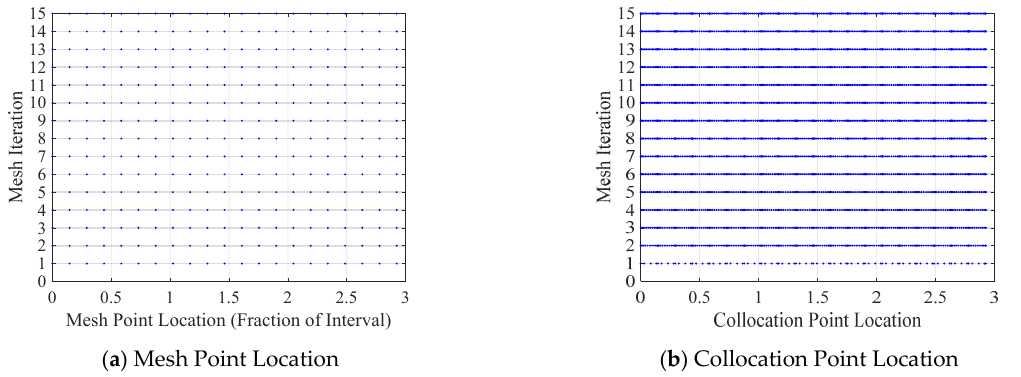
Figure 18. History of mesh point location and collocation point location for retargeting control optimization.